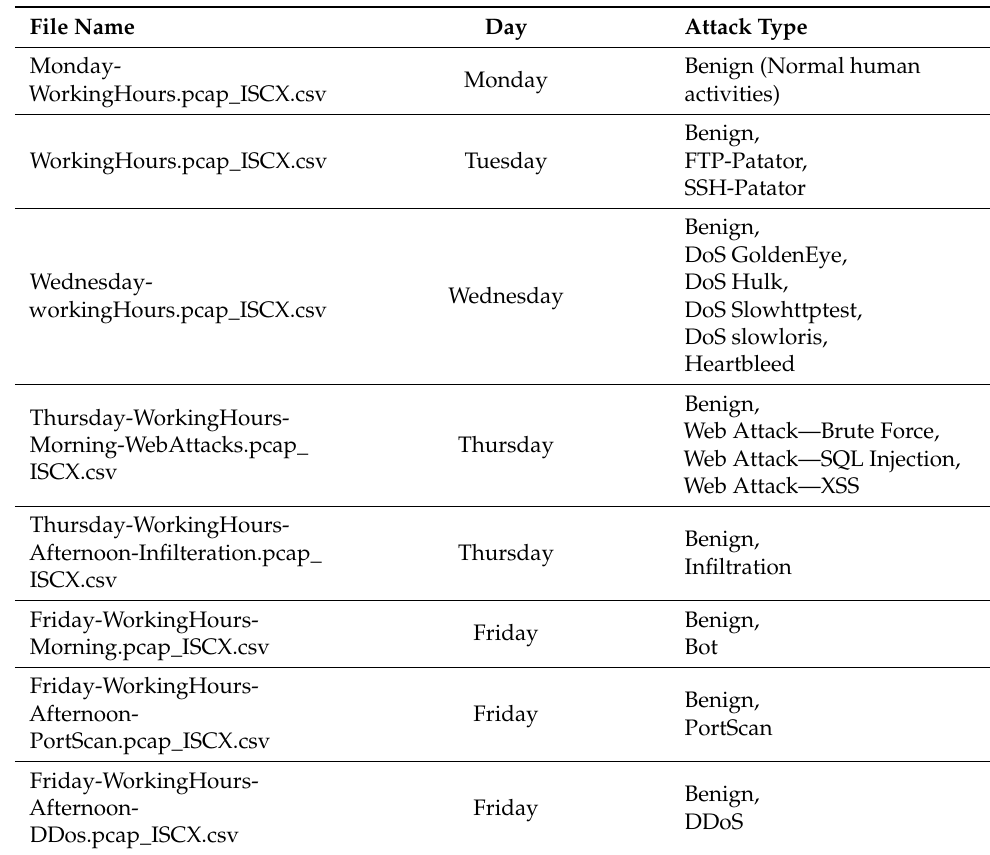
Table 2. Description of CICIDS2017 Dataset.